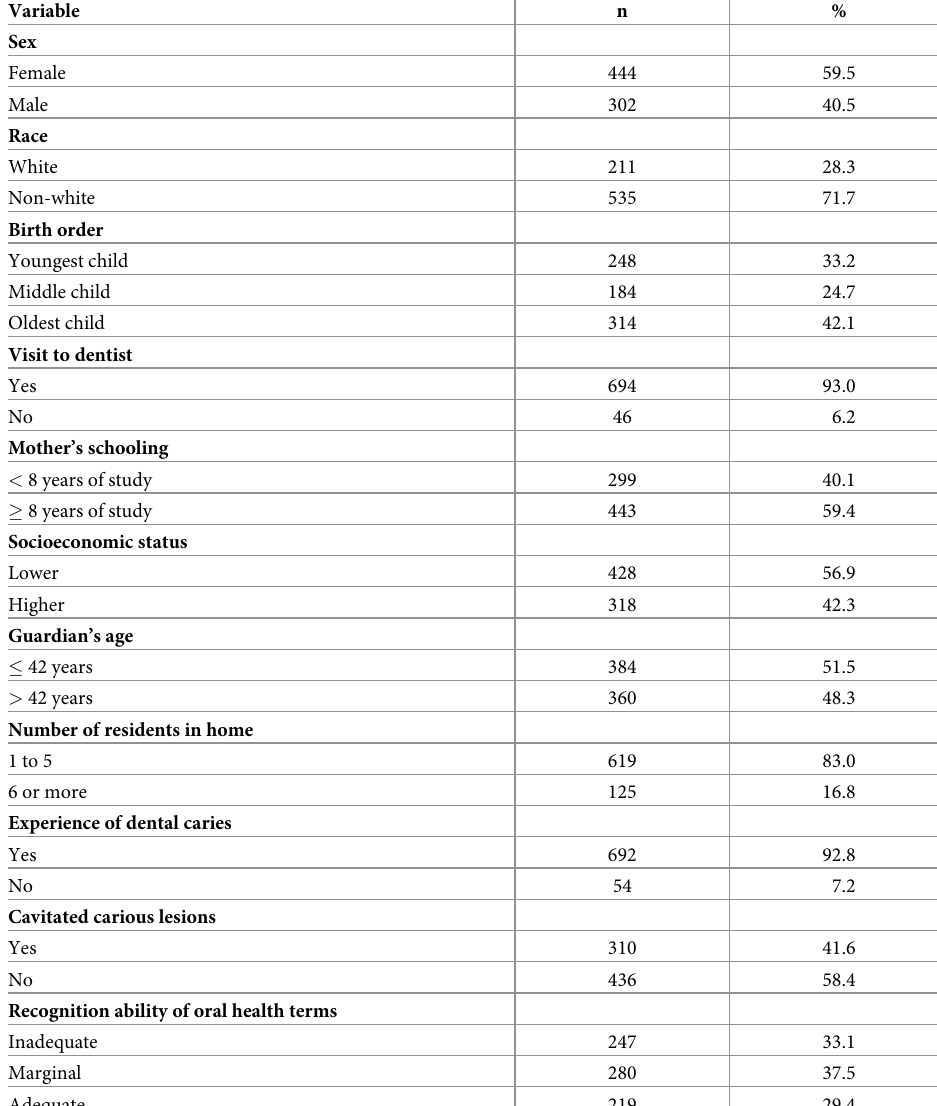
Table 1. Characterization of